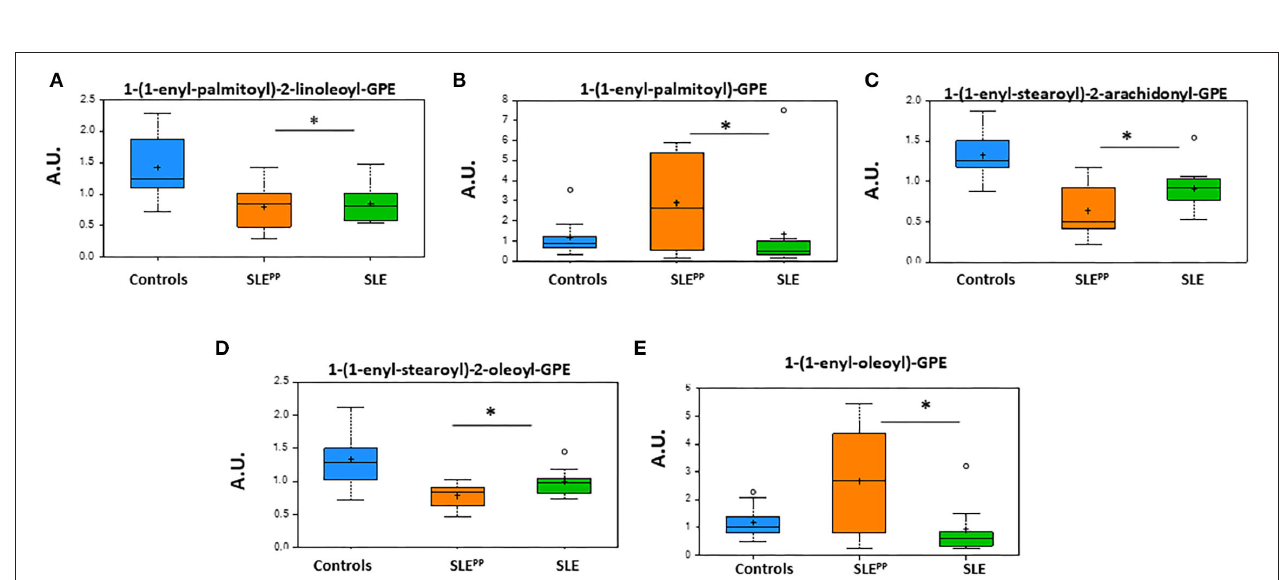
FIGURE 6 | Glycerophosphoethanolamine derivatives of plasmalogens are altered in SLE serum. Indicated in the bar charts in arbitrary units (AU) are plasmalogen derivatives of fatty acids from the metabolic screen which were found to be altered in both SLE and SLE PP sera when compared to non-SLE controls. Baseline serum concentrations from non-SLE controls are indicated in blue, SLE patients who exhibited plaque progression in orange, and control SLE patients in green. While 1-(1-enyl-palmitoyl)-2-linoleoyl-GPE, 1-(1-enyl-stearoyl)-2-oleoyl-GPE, and 1-(1-enyl-stearoyl)-2-arachidonoyl-GPE were reduced in the sera of both lupus groups as compared to the non-SLE controls, 1-(1-enyl-palmitoyl)-GPE and 1-(1-enyl-oleoyl)-GPE were highest in the SLE PP group. All plotted molecules displayed the potential to discriminate between SLE PP and SLE patients, with statistically significant ( p < 0.05) differences in average serum concentrations. Metabolite comparisons between groups were carried out using a Welch’s adjusted unequal variance t- test. * indicates p < 0.05.